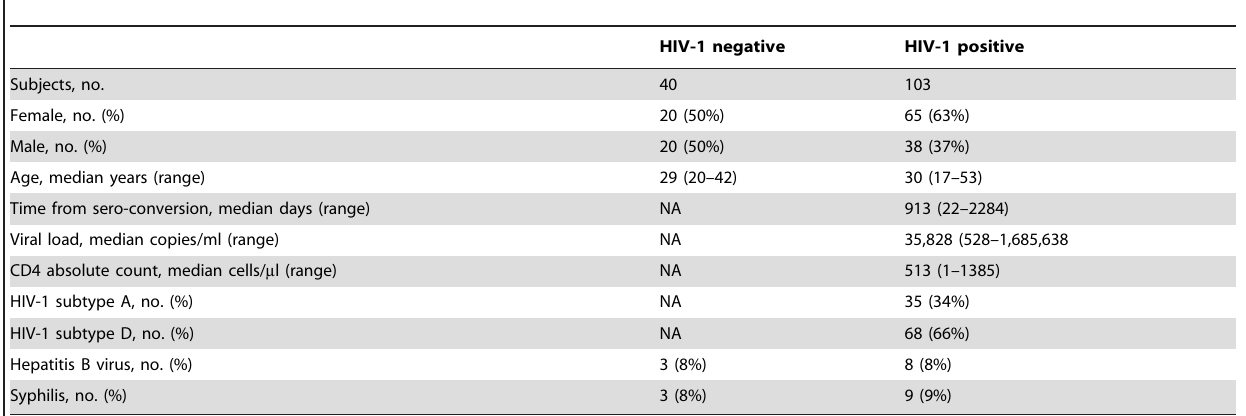
Table 1. Study population descriptive statistics.